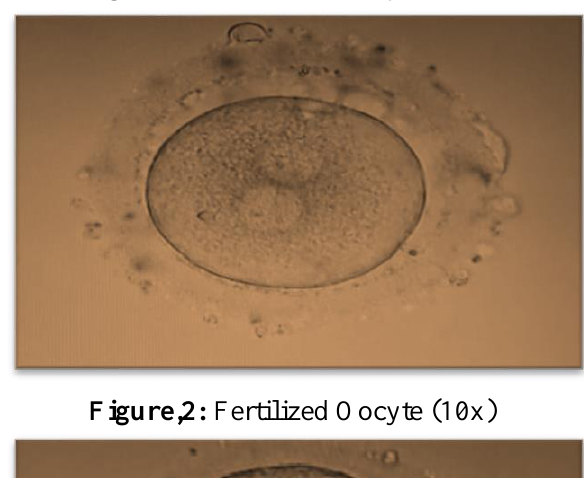
Figure,1: Maturated Oocyte (10x).